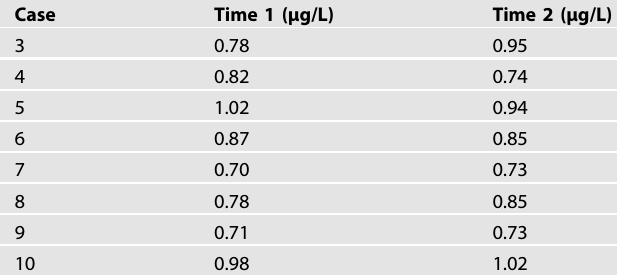
Table 2. Examination of post-mortem change: two measurements of aqueous humor lithium levels 16 h apart.